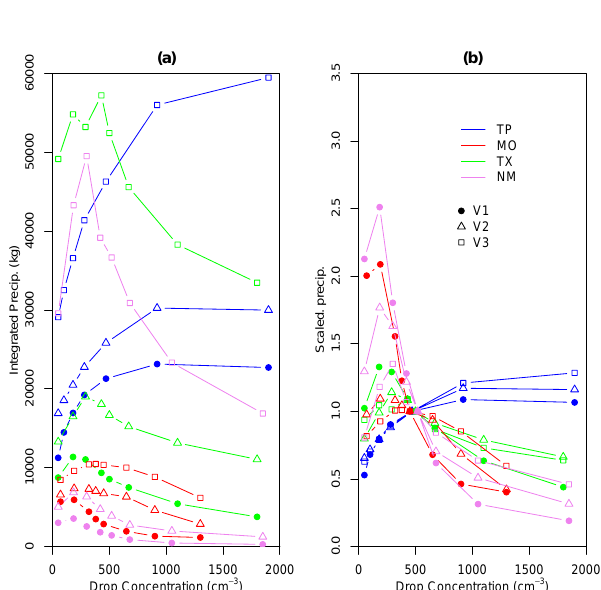
Fig. 3. (a) Change in total accumulated precipitation as a func- tion of the maximum initial cloud drop number for a range of sim- ulated convective clouds due to changes in aerosol from Table 1. Three separate sets of simulations with storm intensities were per- formed in each environment: high (v3), medium (v2) and low (v1). In (b) rainfall is normalised by the model run with a droplet con- centration of 500cm − 3